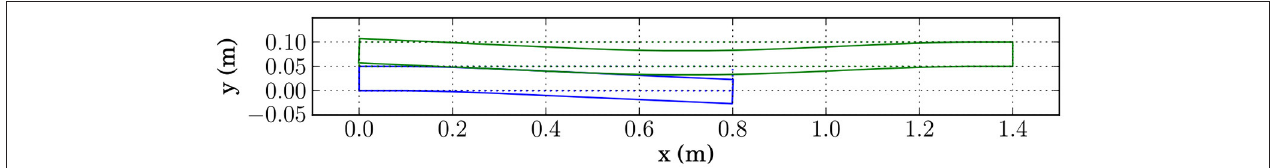
FIGURE 10 | Deformed shape for example A with Signorini contact, with the scale factor of 500.